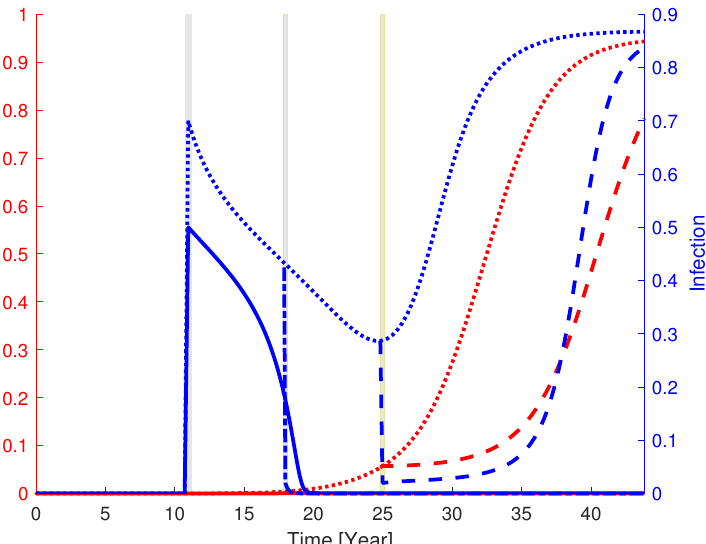
Figure 5. Progression of cancer (red) and infection (blue). Model response to a sudden additional infection introduced at year 11 (left grey region). A threshold value for the additional infection exists, which separates cancer-infection progression (dotted curves) and recovery (full curves). If modest infection is added, the immune system is capable of defeating the infection (full blue curve) while the cancer only blooms slightly before eventually returning to the dormant state level. In the case of high infection, the immune system is not capable of defeating the infection sufficiently fast (dotted curves). The infection is lowered for some time while the cancer grows (dotted curves). However, if the infection is treated sufficiently fast (middle grey region), e.g., 7 days after infection onset (dash dotted curves), then the state comes below the separatrix and the immune system is capable of defeating the growing amount of malignant cells as well as the infection. Treating infection downwards (right grey region/stipulated curves) may be insufficient and result in infection-cancer